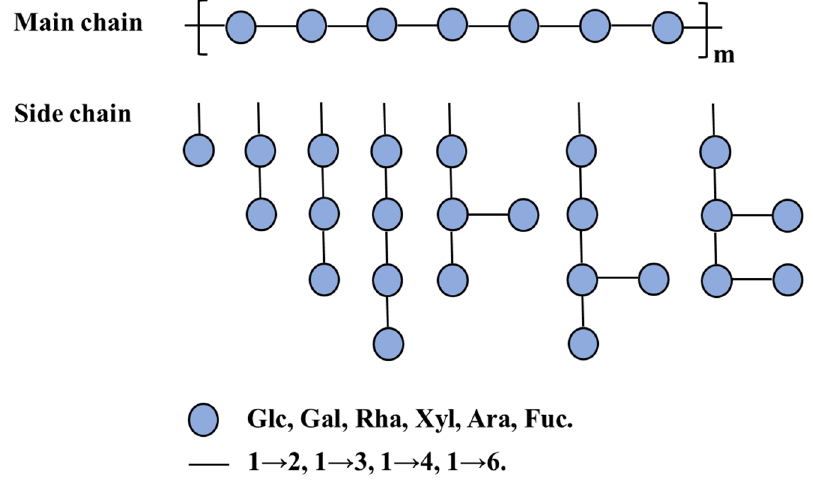
Figure 1. General structure of TPSs.